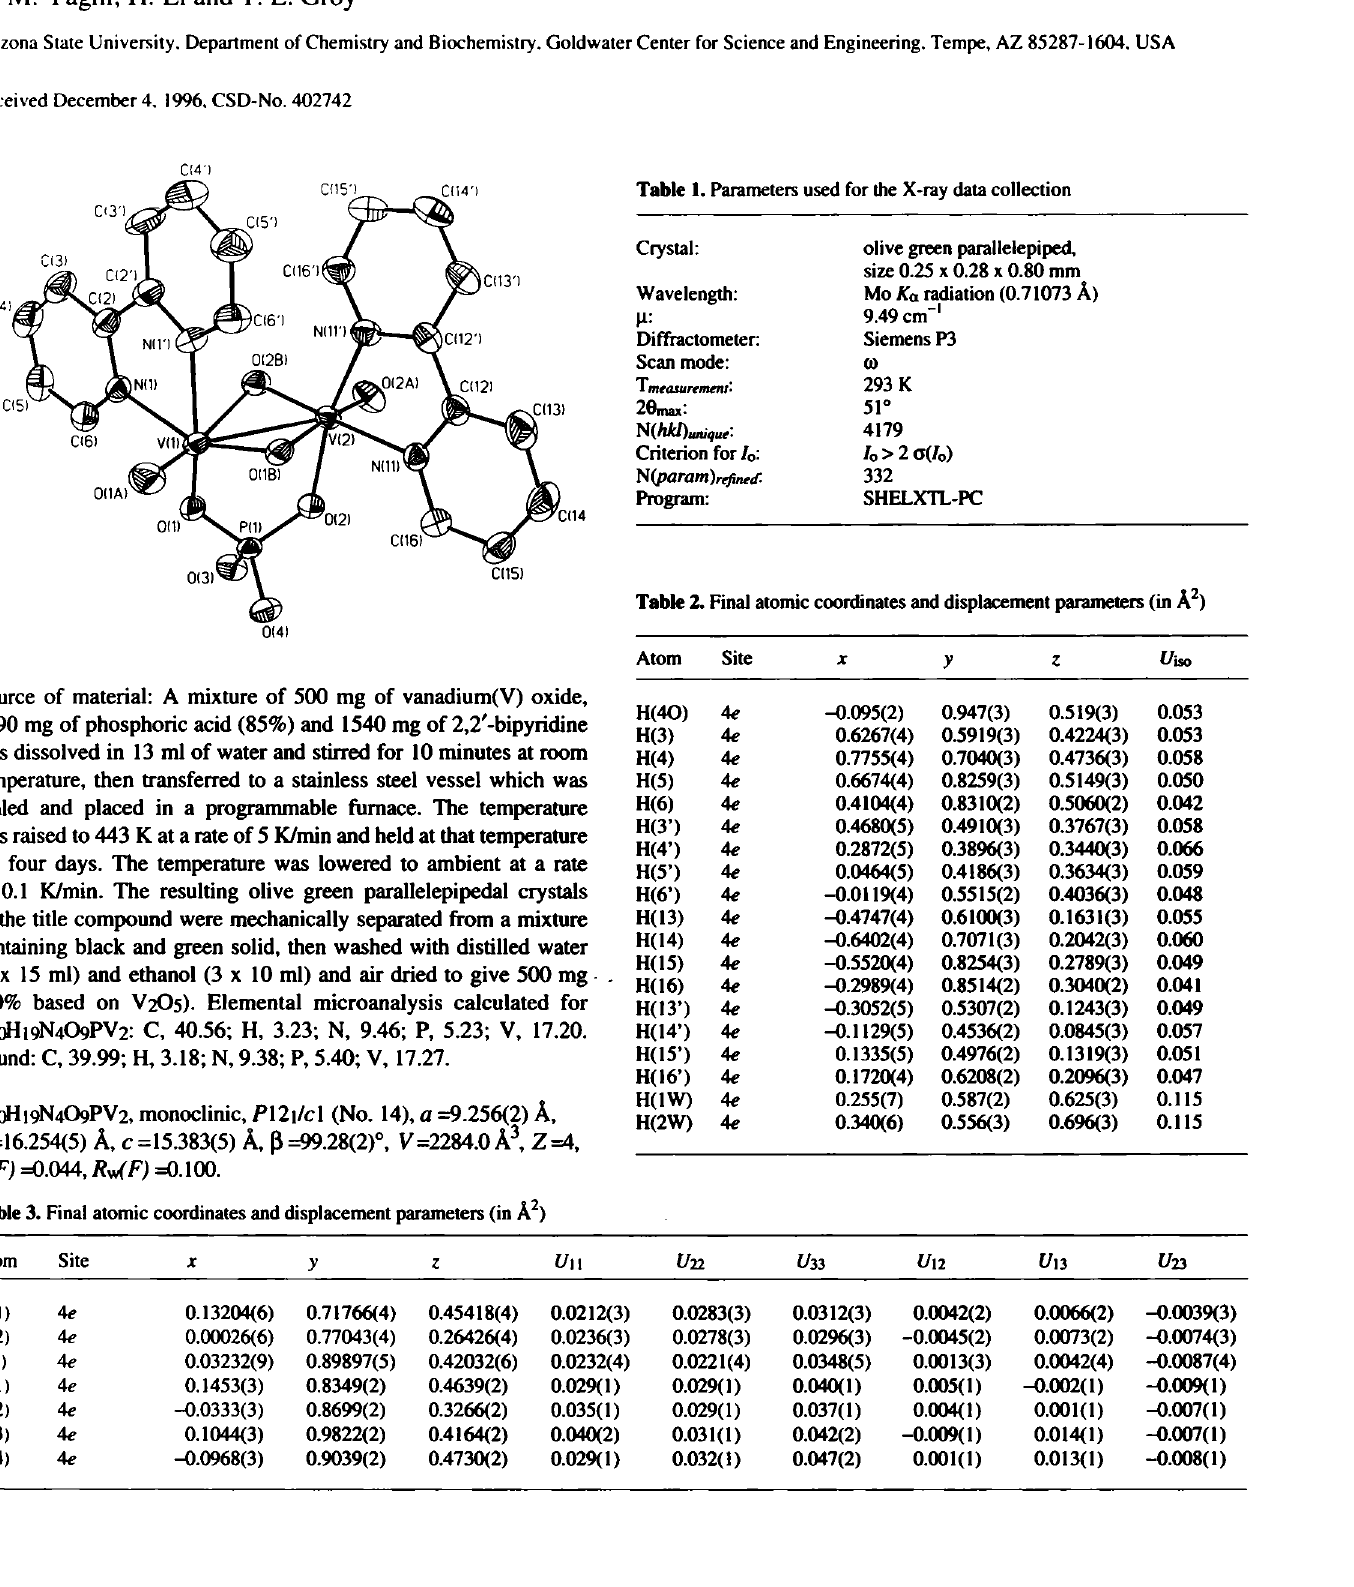
Table 1. Parameters used for the X-ray data collection Crystal: